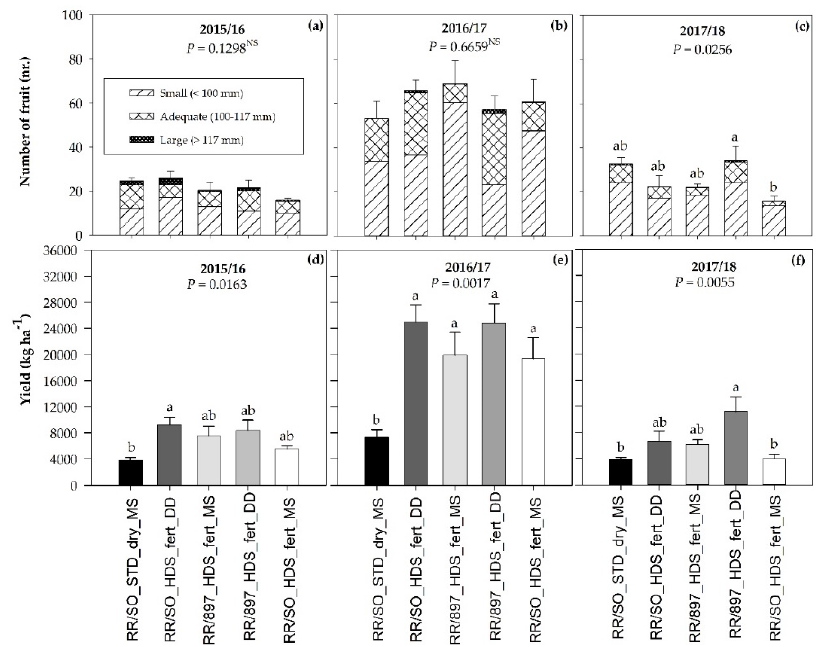
Figure 4. Total number of fruit ( a – c ) and fruit yield ( d – f ) of “Ray Ruby” grapefruit (RR) trees. Treatments: RR / SO_STD_dry_MS = Sour Orange (SO) rootstock + standard spacing (STD, 358 trees per ha) + dry granular fertilizer + microsprinkler (MS), RR / SO_HDS_fert_DD = SO rootstock + high density staggered (HDS, 953 trees per ha) + fertigation (fert) + drip (DD), RR / 897_HDS_fert_ MS = US-897 rootstock + HDS + fertigation + microsprinkler, RR / 897_HDS_fert_DD = US-897 rootstock + HDS + fertigation + drip, and RR / SO_HDS_fert_MS = SO rootstock + HDS + fertigation + microsprinkler. Mean ± standard error followed by di ff erent letters within the same year are significantly di ff erent at p ≤ 0.05 by Tukey’s test ( n = 5). NS = Not significant.